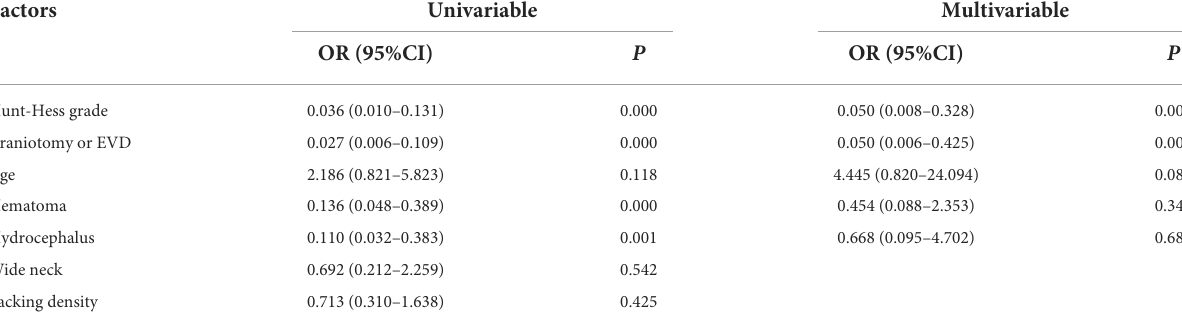
TABLE 1 Univariable and multivariable logistic analyses of risk factors for poor outcomes at discharge.